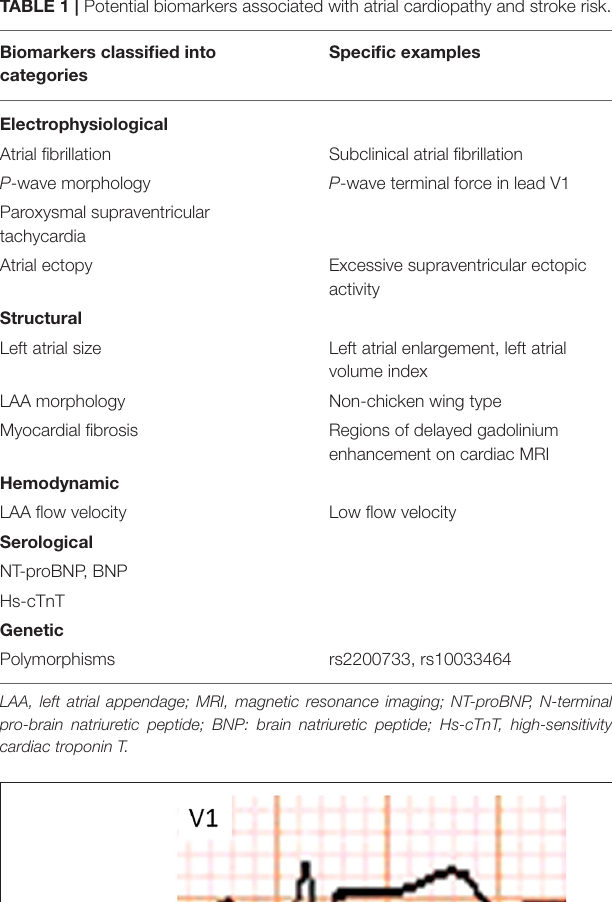
TABLE 1 | Potential biomarkers associated with atrial cardiopathy and stroke risk.